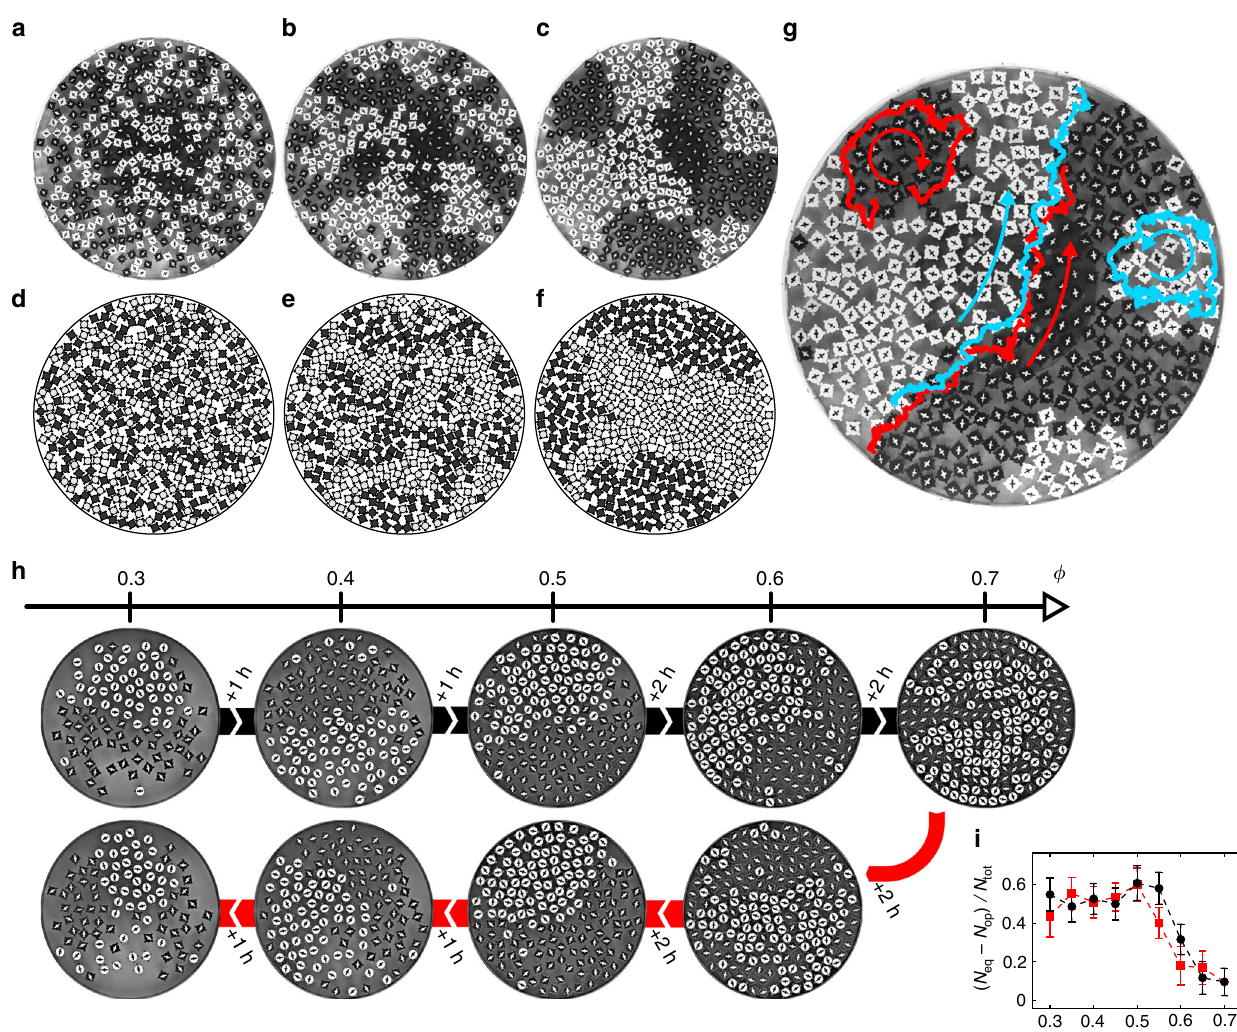
Fig. 2 Phase separation of a binary mixture of rotors. Experimental system at times a 10 s, b 60 s, c 900 s after initialization. d – f Snapshots of computer simulations at the same times. g Rotors at the interface perform super-diffusive motion along the interface. Representative trajectories are shown for clockwise transport of clockwise spinning particles (black particles, red trajectories) and counter-clockwise transport of counter-clockwise spinning particles (white particles, blue trajectories). Arrows indicate the direction of motion. For further visualizations of edge currents see Supplementary Fig. 2 – 3 and Supplementary Movies 2, 3. h Snapshots of the system at different packing fractions after successively adding and then removing particles. Segregation occurs in a wide range of packing fractions of ϕ = 0.3 – 0.6 and breaks down at larger ϕ . i Relative difference of equal and opposite nearest neighbors ( N eq − N op ) / N tot during a time interval of 20 min at fi xed ϕ . Error bars are de fi ned as standard deviation. For 0 : 3 (cid:4) ϕ ≲ 0 : 55, the relative difference is independent of packing fraction indicated by a (Fig. 5a, b) by fi tting the slope of the MSD (Fig. 5c). The driving torque is given by j τ D j ¼ γ R ω in the steady state. It is only weakly